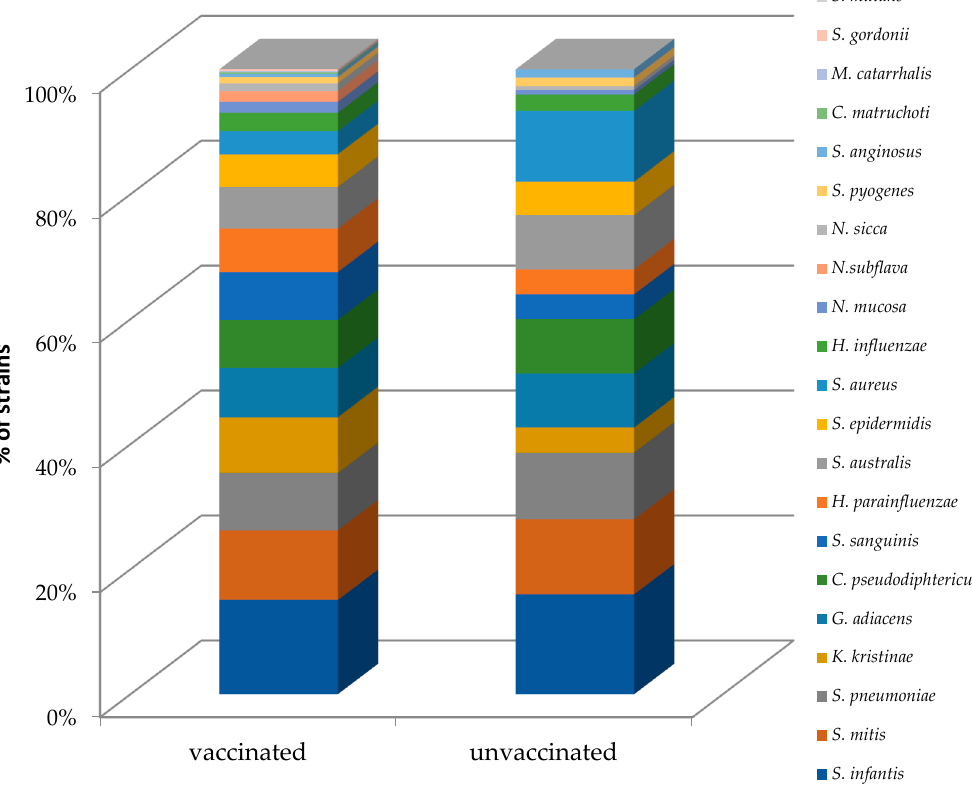
Figure 2. Bacterial frequency analysis in the vaccinated and unvaccinated groups.